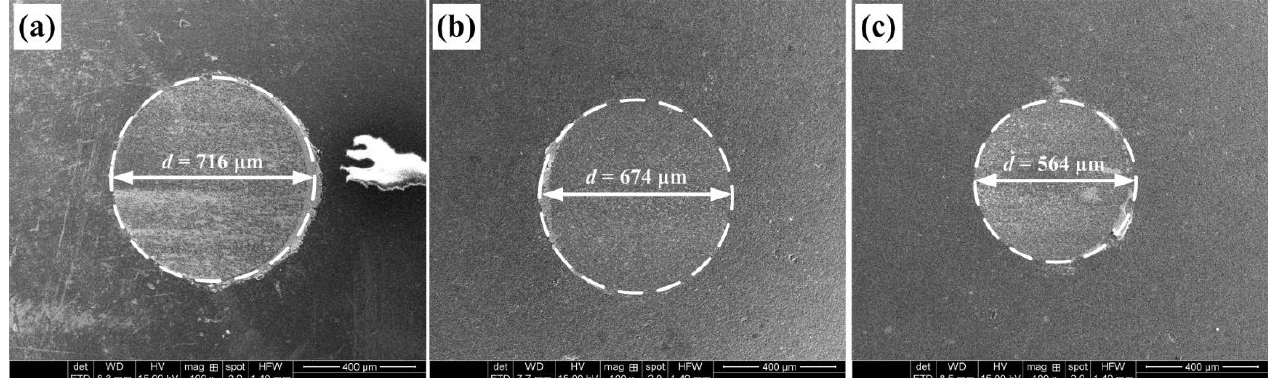
Figure 7. SEM images of the worn surface of the ceramic balls sliding with ( a ) SS, ( b ) TD150 and ( c ) TD150 with lubricants after 10 min dry operation at the speed of 40 m/min. The schematic diagram of wear loss for the worn ceramic ball is shown in Figure 8. ume of the worn ball can be calculated as